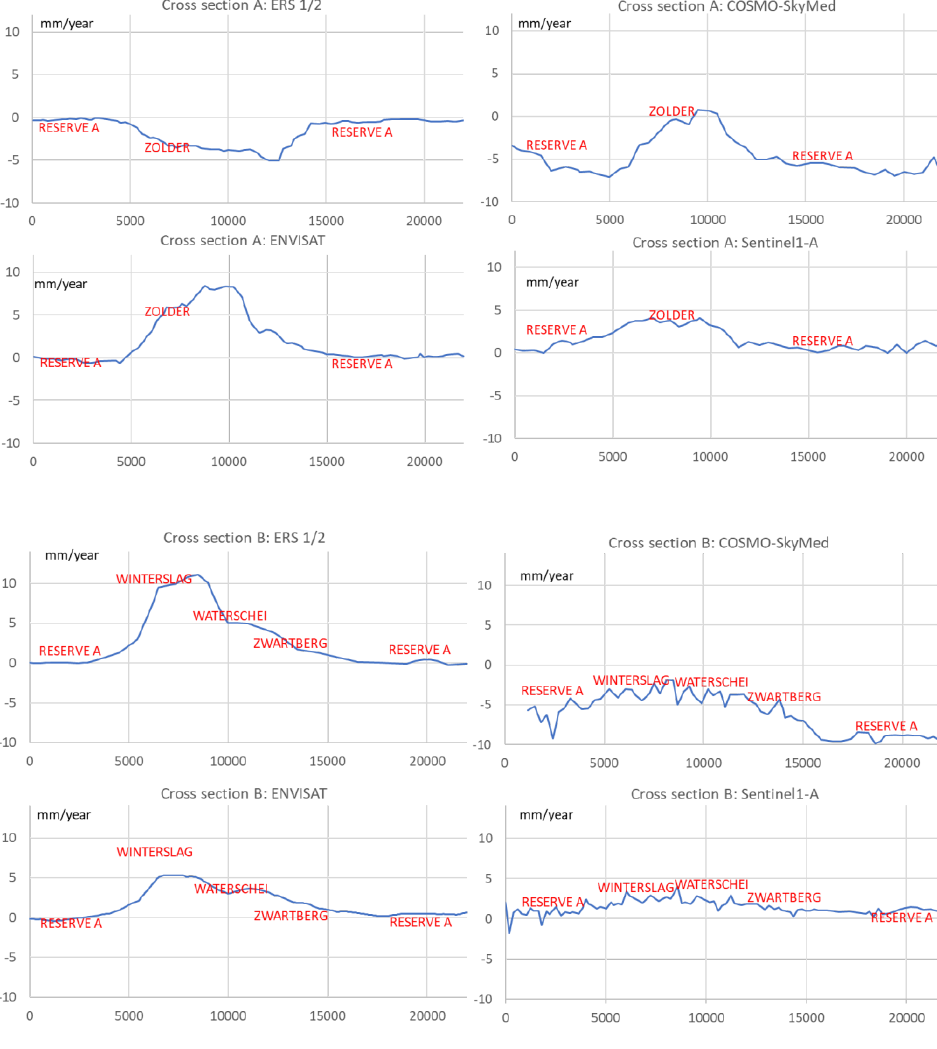
Figure 14. The evolution of LOS-velocity values of PS points averaged an over 200 m buffer across the paths A and B (cf. Figure 13) for the 4 SAR datasets (cf. Table 1).